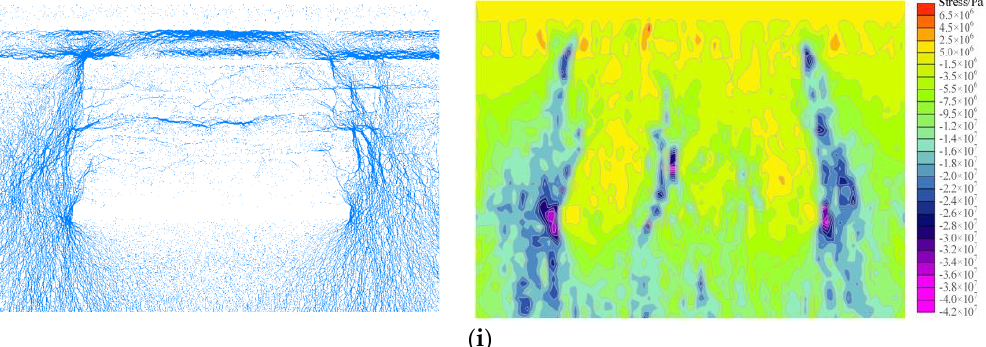
Figure 23. Stress evolution law of overburden rock. ( a ) Working face advancing 10 m; ( b ) Working face advancing 20 m; ( c ) Working face advancing 30 m; ( d ) Working face advancing 40 m; ( e ) Working face advancing 50 m; ( f ) Working face advancing 60 m; ( g ) Working face advancing 70 m; ( h ) Working face advancing 80 m; ( i ) Working face advancing 90 m.